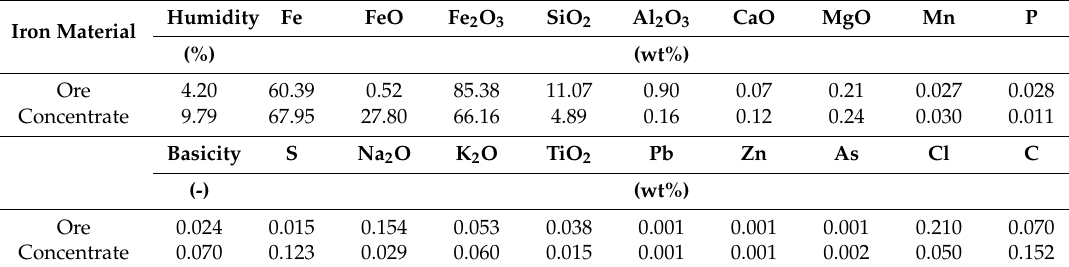
Table 2. Chemical analysis of Fe materials.